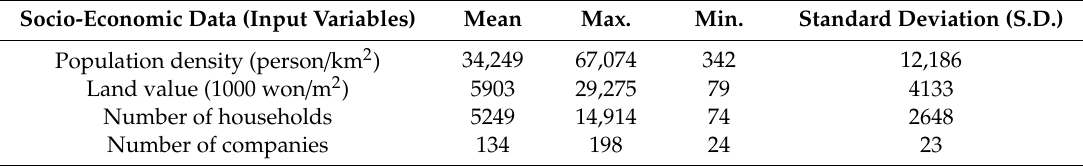
Table 2. Descriptive statistics of the socio-economic data.